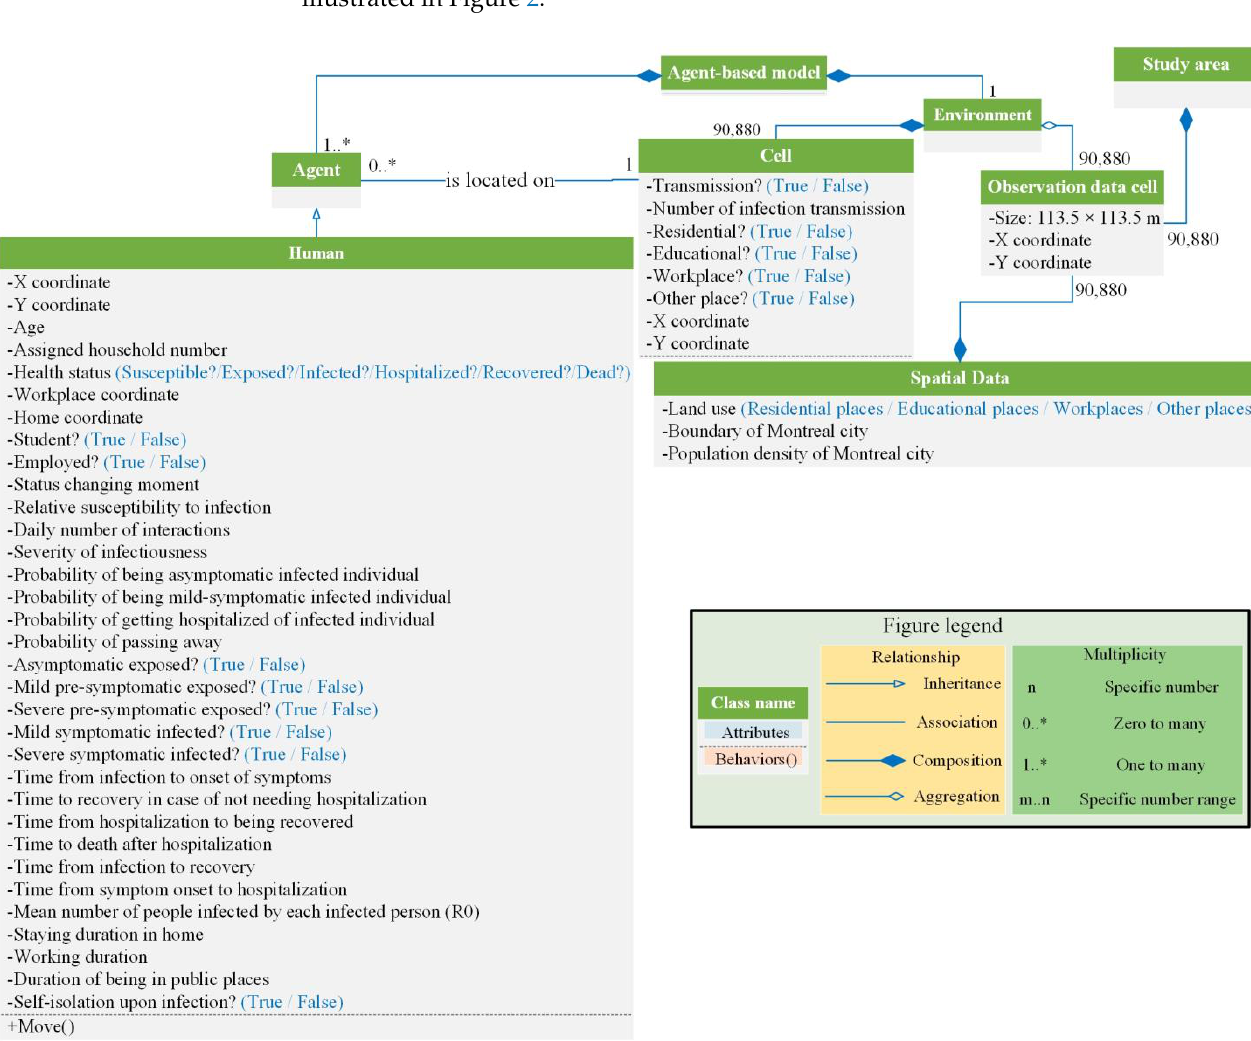
Figure 2. Representation of the components of the proposed